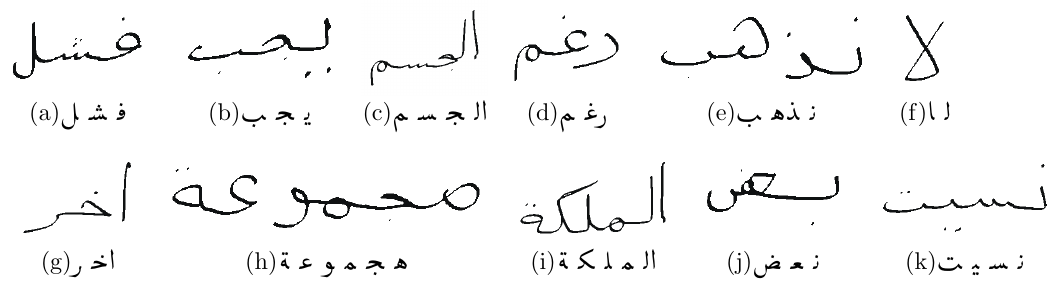
(cid:130)(cid:9) (cid:175) , (cid:73)(cid:28)(cid:10)(cid:130)(cid:9) (cid:29)